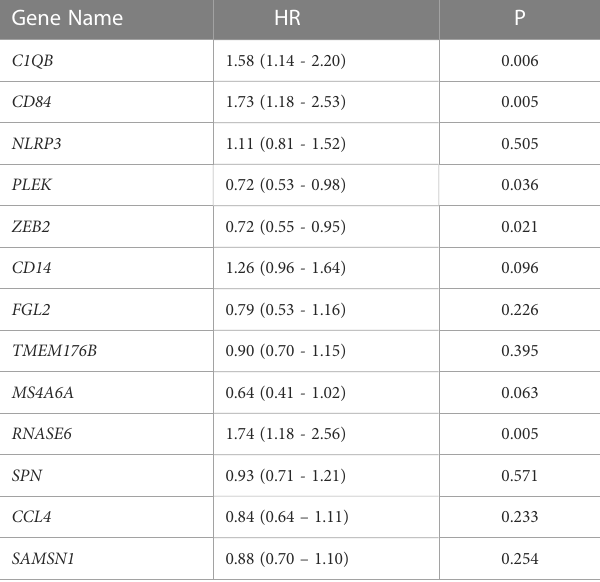
TABLE 1 Multivariate Cox analysis of the 13